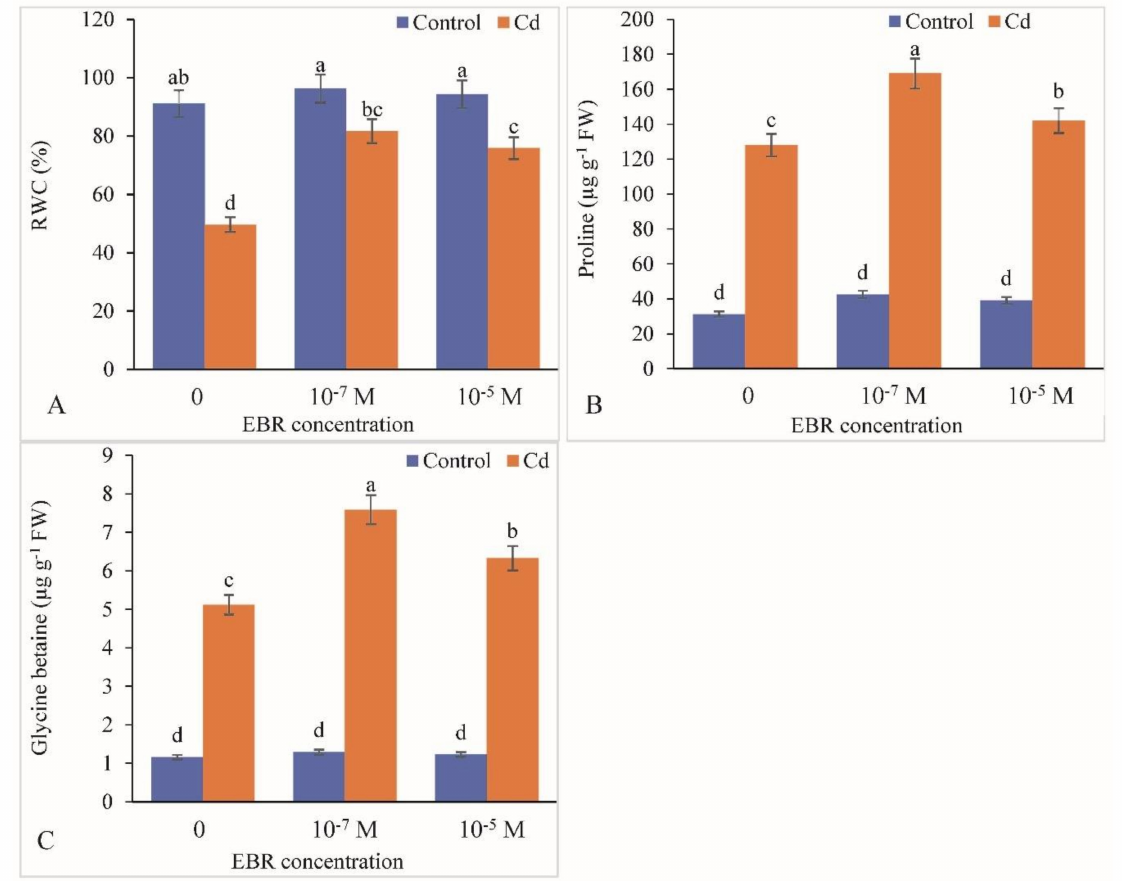
Figure 5. Application of 24-Epibrassinolide enhanced leaf ( A ) RWC, ( B ) proline content and ( C ) glycine betaine in B. juncea under Cd (200 µ M) stress. Values with di ff erent letters above the bars are significantly di ff erent at each measured time point ( p < 0.05) (Mean ±